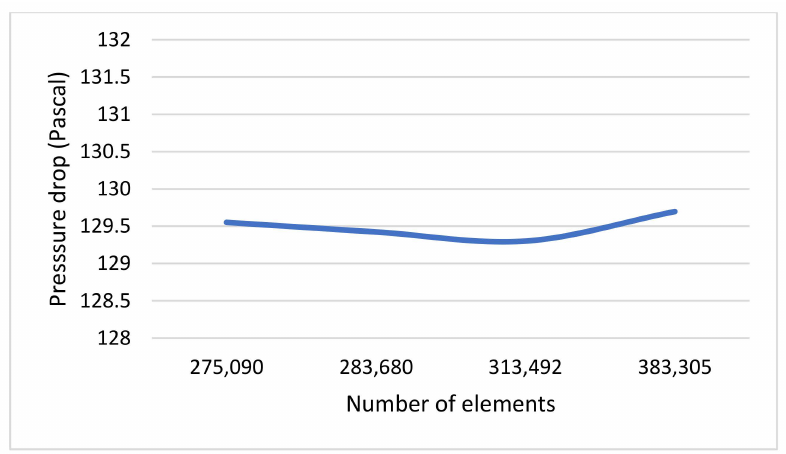
Figure 5. Grid independence test on the pressure drop across the